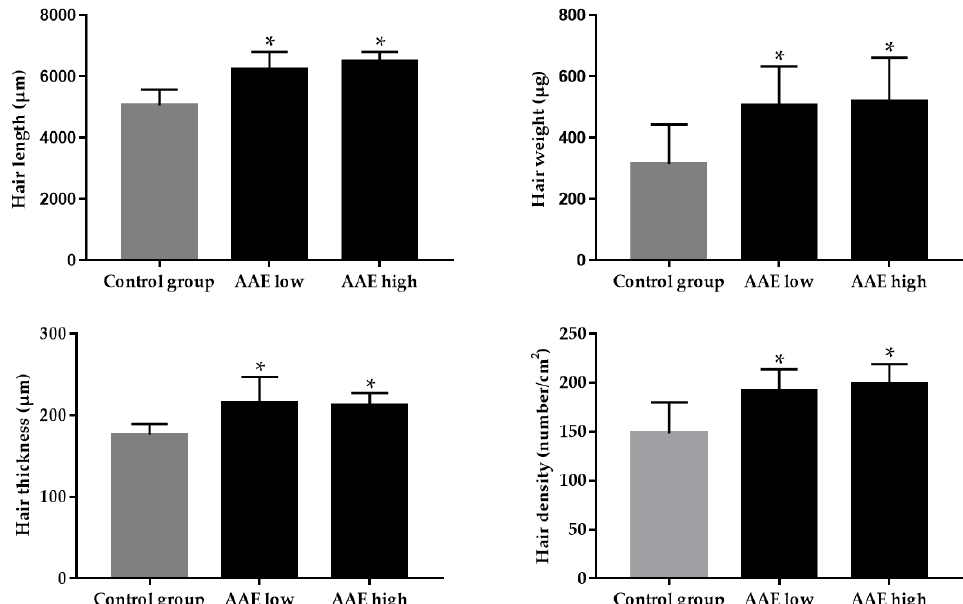
Figure 2. Comparison of hair length, weight, thickness, and density after three weeks of continuous treatment in the C57BL/6 mice. Both low and high AAE groups showed significantly increased hair length, thickness, weight, and density compared to the control. * p < 0.05 compared to the control group.